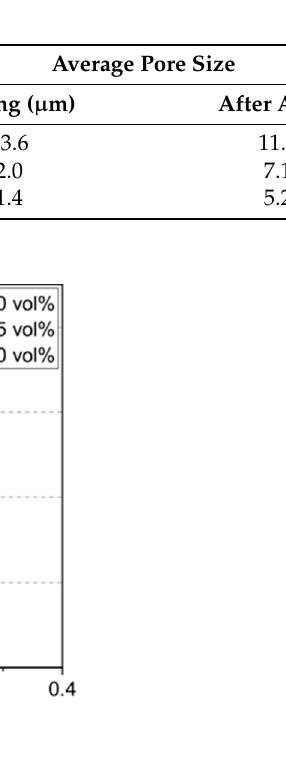
Table 3. Summary of pore size measurements determined from SEM images before and after thermal aging at 1400 °C for 96 h.